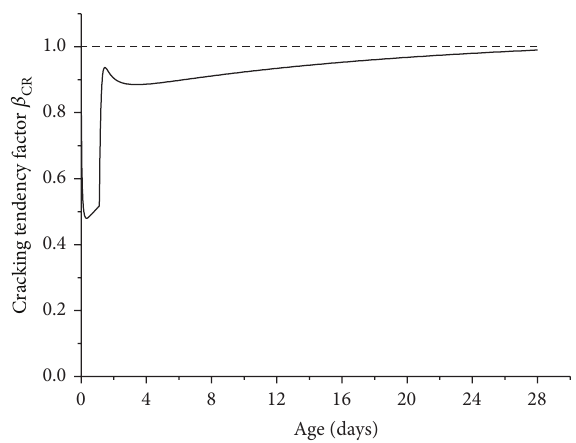
Figure 12: Cracking tendency of early-age mortar